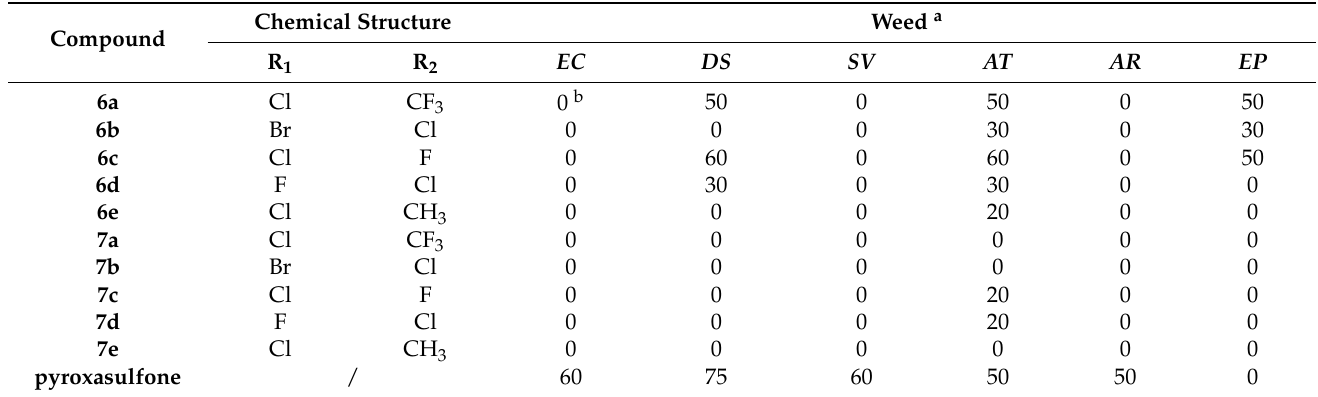
Table 1. The structures and herbicidal activities of pyrazole derivatives at a 150 g a.i./hm 2 post- emergence treatment dose in a greenhouse assay